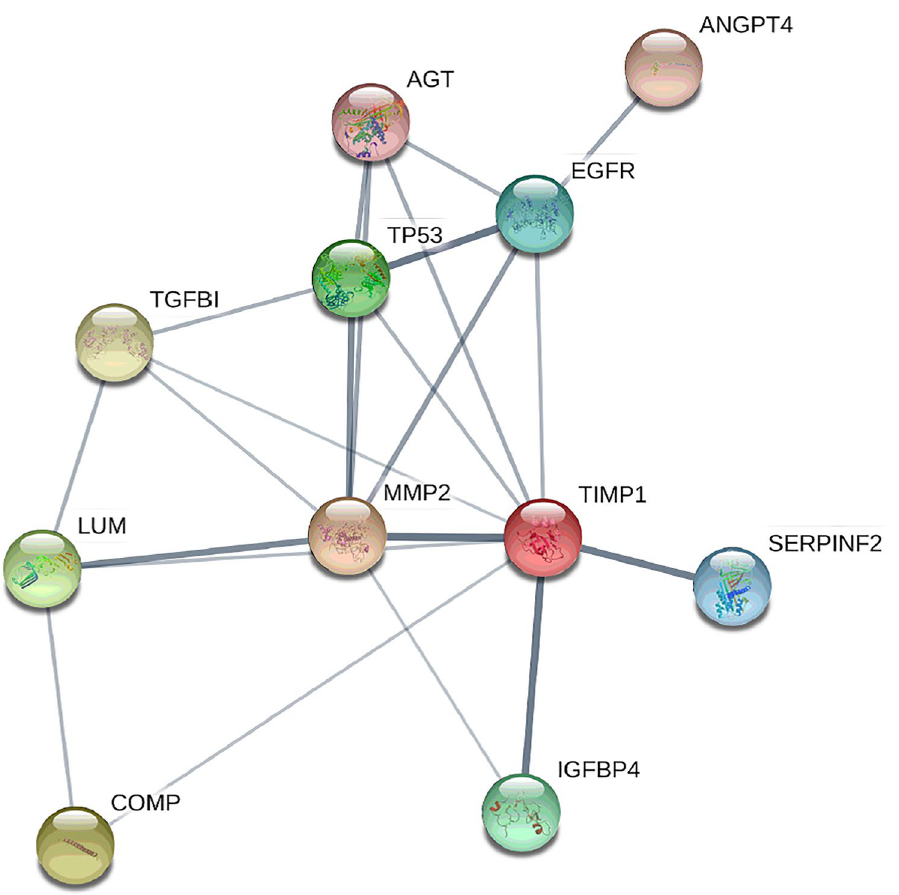
Figure 6. Analysis of protein–protein interactions from the STRING database for association networks. These revealed several direct (thick lines) and indirect (thin lines) interactions of the biomarker candidates. See Table 3 for protein name